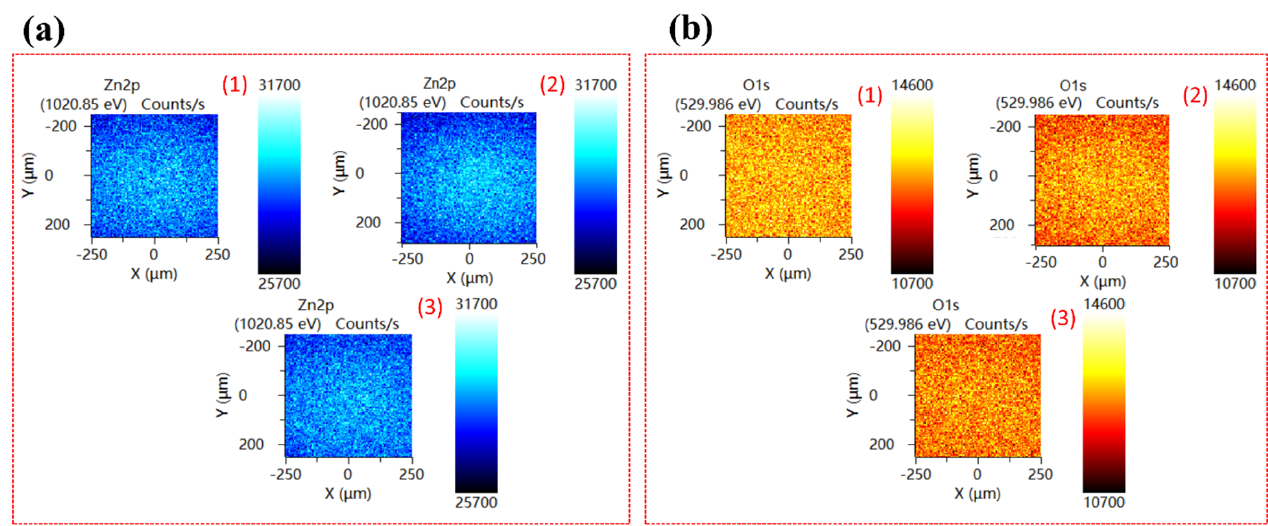
Figure 3. XPS core-level mapping of ( a ) Zn 2p and ( b ) O 1s ZnO single crystals; with polar (1) <0001>, and non-polar (2) <1010>, (3) <1120> orientations.